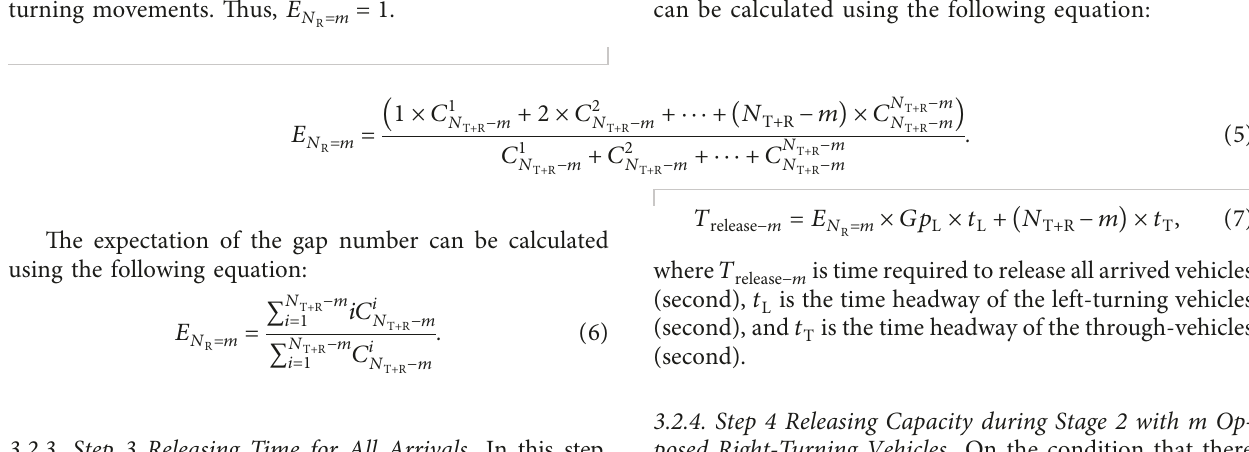
Figure 5: Opposing right turns provide opportunities for the crossing of left-turning